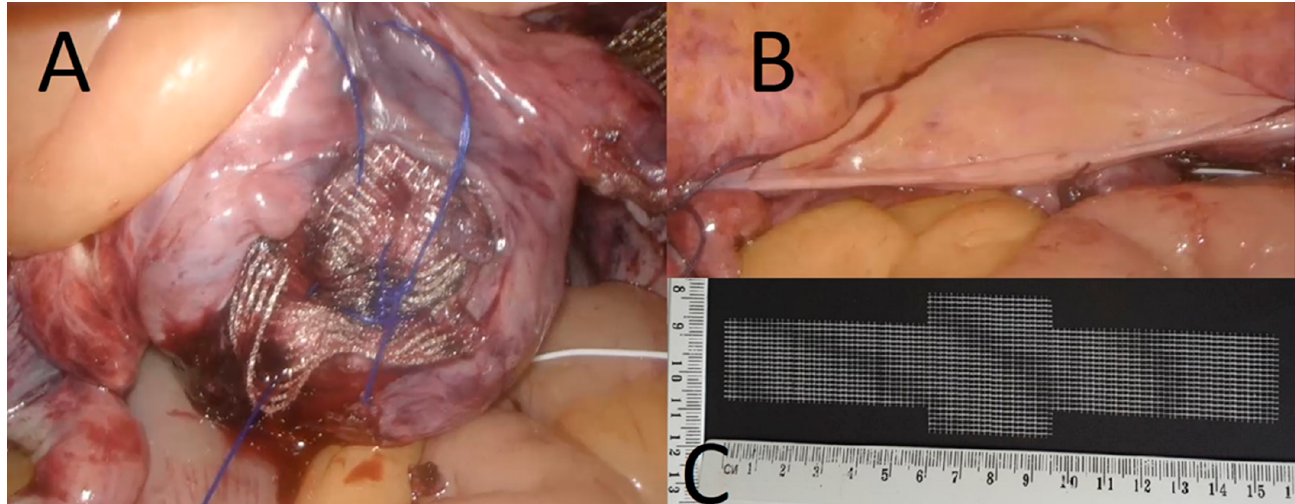
Figure 2. Laparoscopic pectopexy—( A ) placement of mesh sutured to the vaginal vault, ( B ) final view from the end of the surgery and ( C ) mesh used in this procedure.